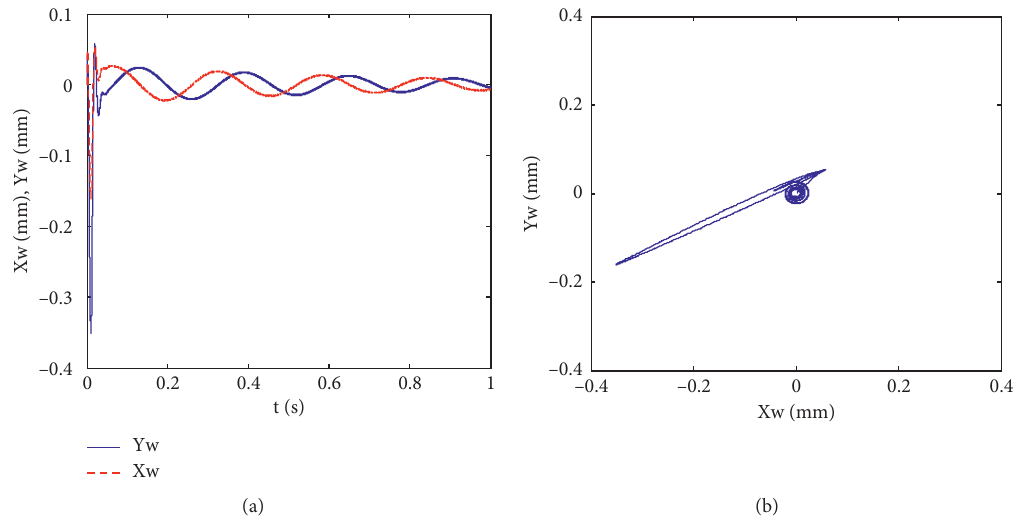
Figure 4: The displacement at the workpiece position based on the conventional PID: (a) displacement diagram in the x and y direction; (b) running track at the position of the